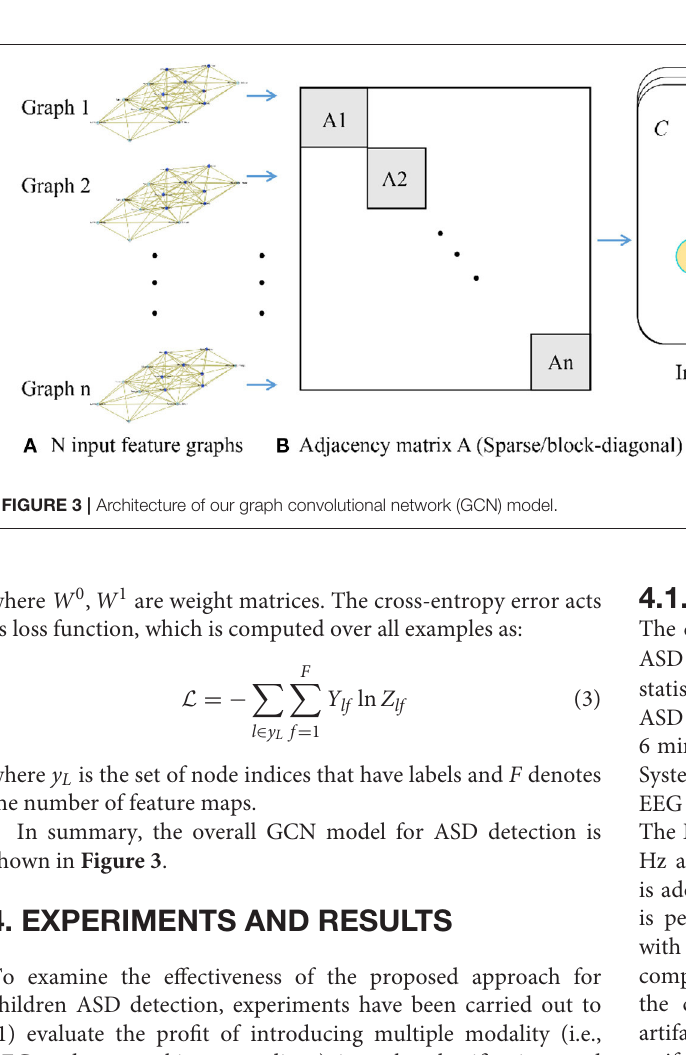
FIGURE 2 | The constructed feature graph.